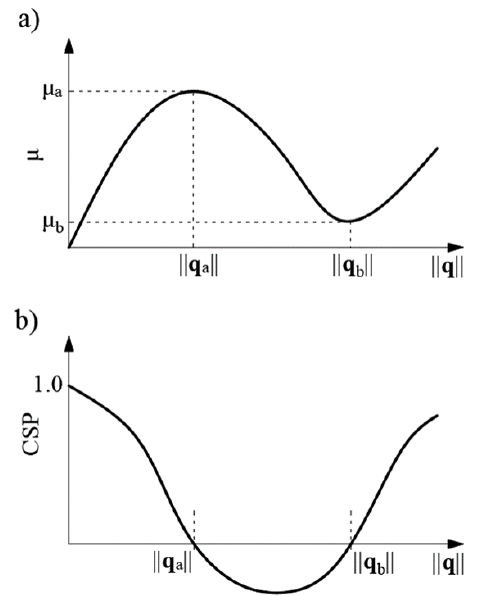
Figure 1. ( a ) Dependence of load parameter µ on the norm of || q || ; ( b ) dependence of the current stiffness parameter (CSP) on the norm of || q || .